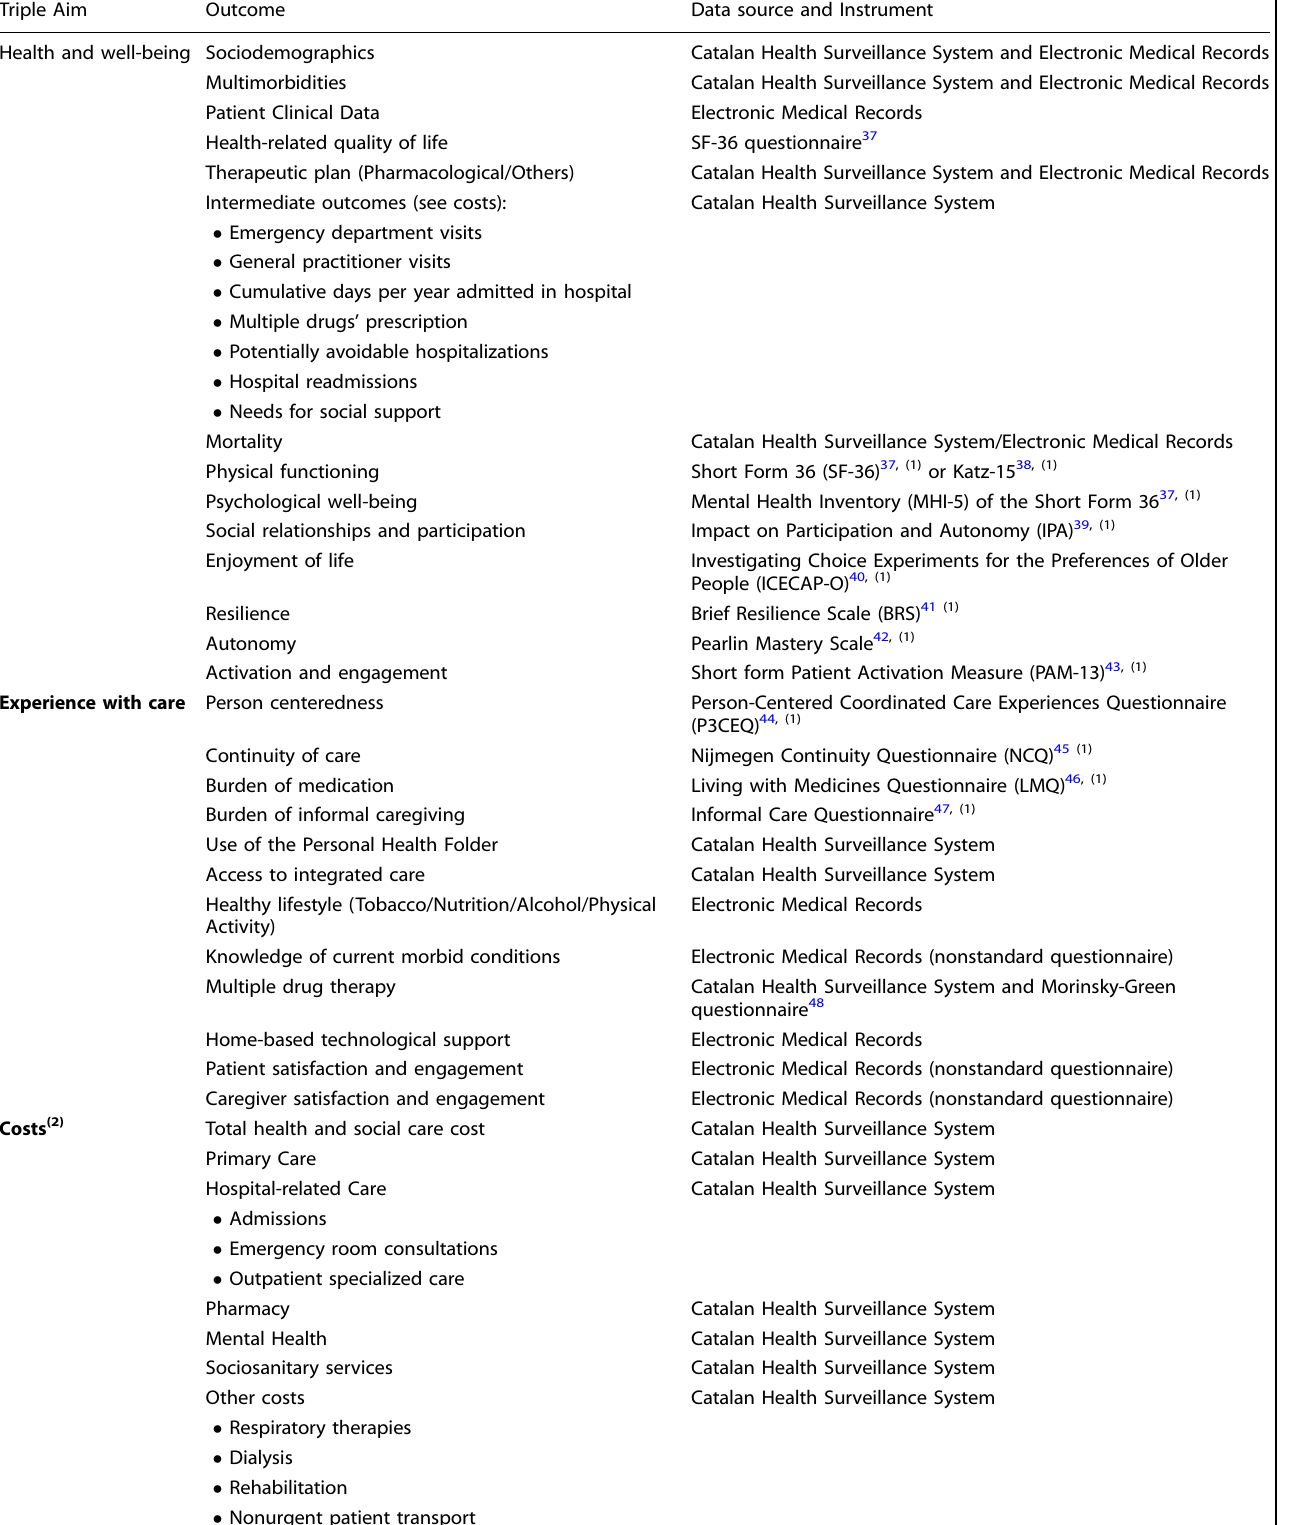
Table 1. Prede fi ned outcome variables for evaluation purposes selected with a “ Triple Aim ”